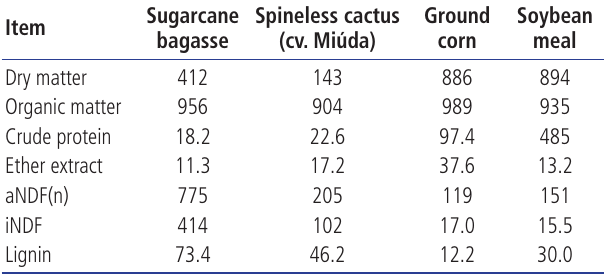
Table 1. Chemical composition of ingredients used in the experimental diets